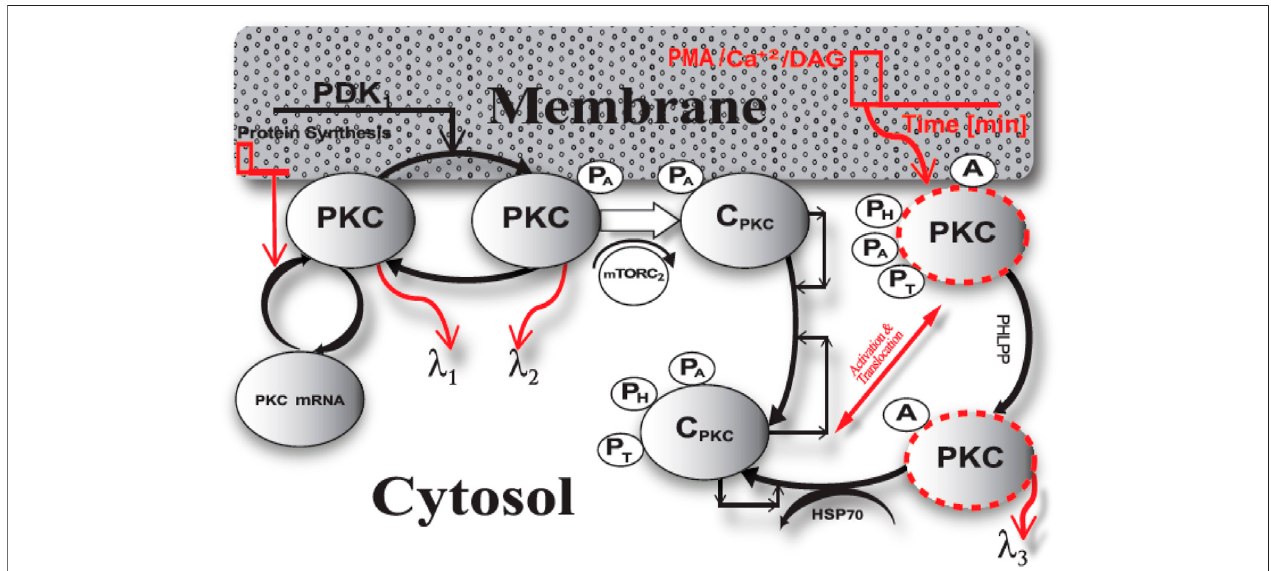
FIGURE 1 | The life cycle model of PKC enzyme. This model explains the fate of naïve, PKC molecule. PKC life cycle has two phases a) constitutive phase and b) agonist-evoked phase. The constitutive phase engages in stabilization and maturation processing of newly synthesized enzyme. Here, the newly synthesized unphosphorylated cPKC is highly unstable. This model describes that constitutively active upstream kinase, PDK1, modulates the phosphorylation of activation loop (P A ). This initial phosphorylation stabilizes the labile enzyme and triggers two sequential phosphorylation events on the C-terminal tail i.e., hydrophobic and turn motif phosphorylation events (P H & P T ). These three constitutive ordered phosphorylation events generate a mature, phosphatase/protease resistant molecule (CPKC.P A .P H .P T ).AsperthismodelabriefsecondmessengerpulseatthemembranecompartmentcanleadtotranslocationandactivationofmaturePKCenzymeand second messenger binding at membrane transforms the inactive mature molecule to active specie i.e., C.PKC.P A .P H .P T A . This active molecule is prone to dephosphorylation and on PHLPP-mediated dephosphorylation event relocates back to cytosol where either it can be either degraded or re-phosphorylated through hsp70 and autophosphorylation-mediated events. C.PKC.P A .P H .P T is cytosolic and on activation stimulation it translocates to membrane. The active form of enzyme at membranePKC. P A .P H .P TA undergoesPHLPPmediateddephosphorylationandactive but dephosphorylatedformat membranei.e.,PKC A translocate backtocytosol where it can undergo degradation or re-phosphorylated to become part of a stable pool of the